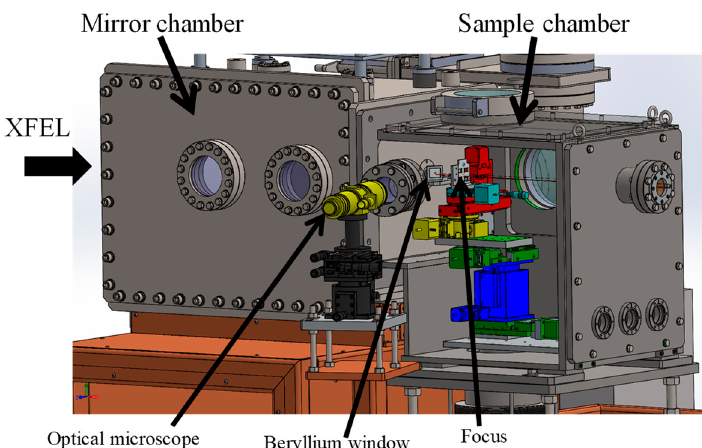
Figure 2. Schematic drawing of the mirror and the sample chamber. The wall on the near side of the sample chamber is presented as transparent to show the inside of the chamber. A beryllium window separates the mirror and sample chambers. An optical microscope is used to observe the sample at the focus from outside the vacuum chamber. Various sample environments, stage arrangements and sample supply systems can be operated utilizing a 100-mm space upstream of the focus. Both the downstream side and the upper side and one lateral side of the sample chamber can be altered to have a large exit port allowing the data collection for forward scattering geometry, X-ray diffraction and X-ray emission spectroscopy. Furthermore, the sample chamber can be altered based on experimental requests while keeping the mirror chamber unchanged.